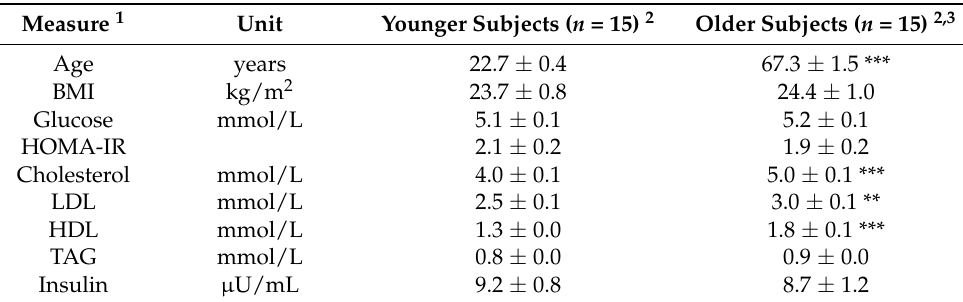
Table 2. Baseline subject